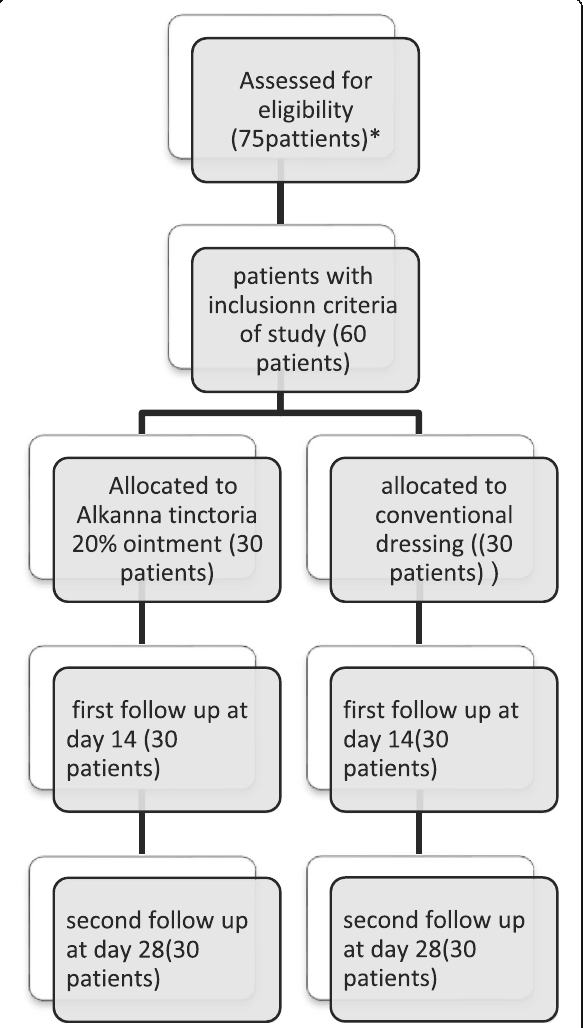
Fig. 1 Consort flowchart of the study.*Seven diabetic patients, three patients with chronic kidney disease and five patients who were unwilling to participate in the study were